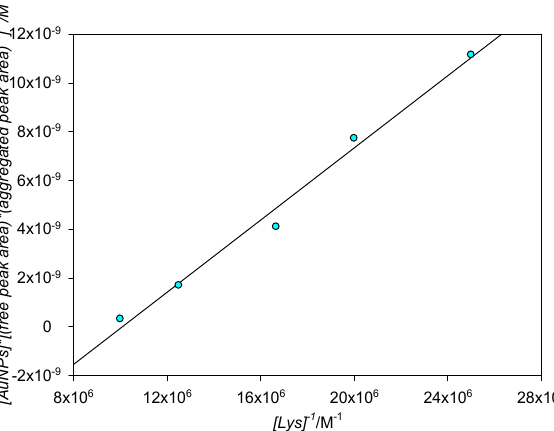
Figure 13. Benesi–Hildebrand plot for aggregated/free area quotients for [Lys] = 4 × 10 − 8 M–1 × 10 − 7 M.